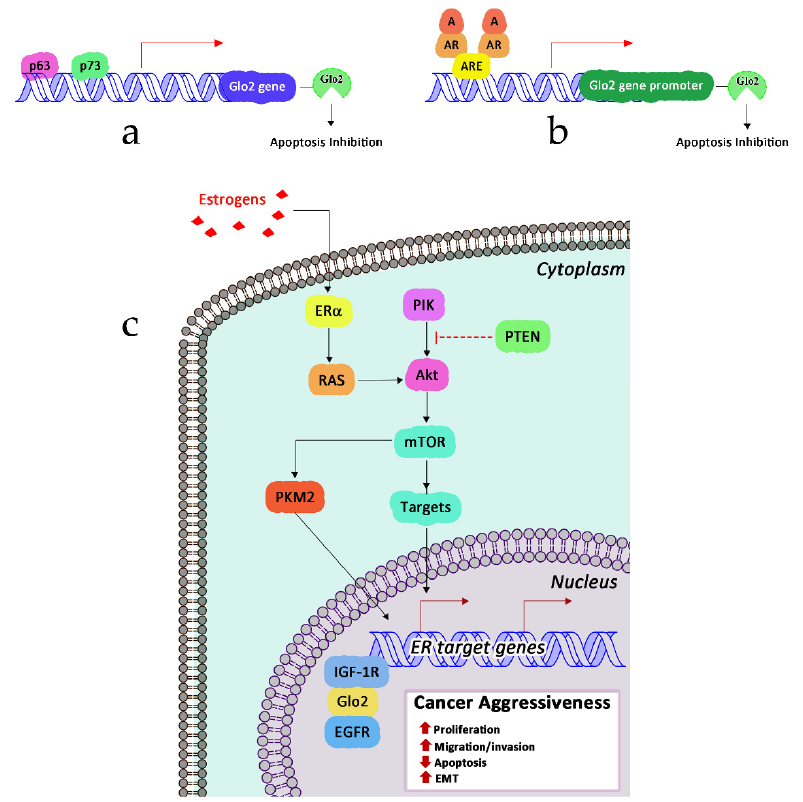
Figure 6. Glo2 and signaling pathways. ( a ) Transcription factor p63 and p73; ( b ) androgen receptor (AR); ( c ) phosphoinositide 3-kinase (PI3K)/protein kinase (AKT)/mammalian target of rapamycin (mTOR) signaling mediated by estrogen receptor alpha (ER α ) activation acts as a positive regulator of Glo2 transcription. A, androgen; AR, androgen receptor; ARE, androgen response element; EGFR, epidermal growth factor receptor; IGF-1, insulin-like growth factor.